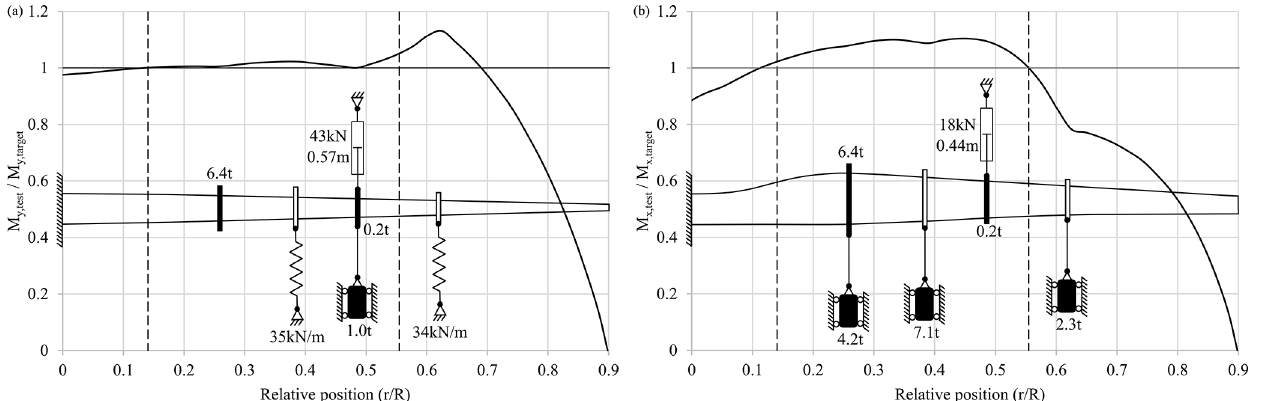
Figure 7. Schematic of biaxial setup and test/target load ratio in flapwise (a) and lead-lag (b) directions.